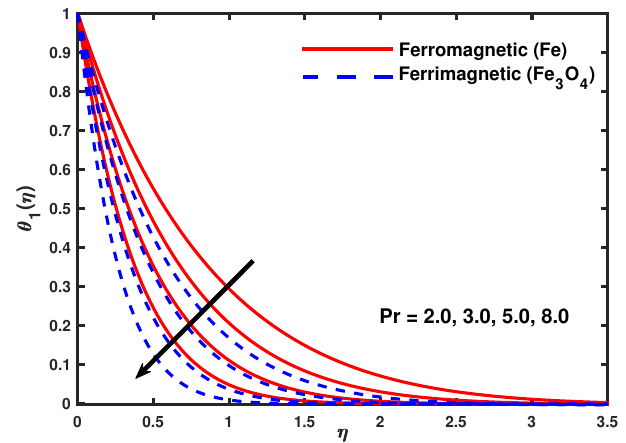
Figure 11. Impact of magnetic nano-particles and Prandtl Number ( Pr ) on the temperature profile θ 1 ( η )